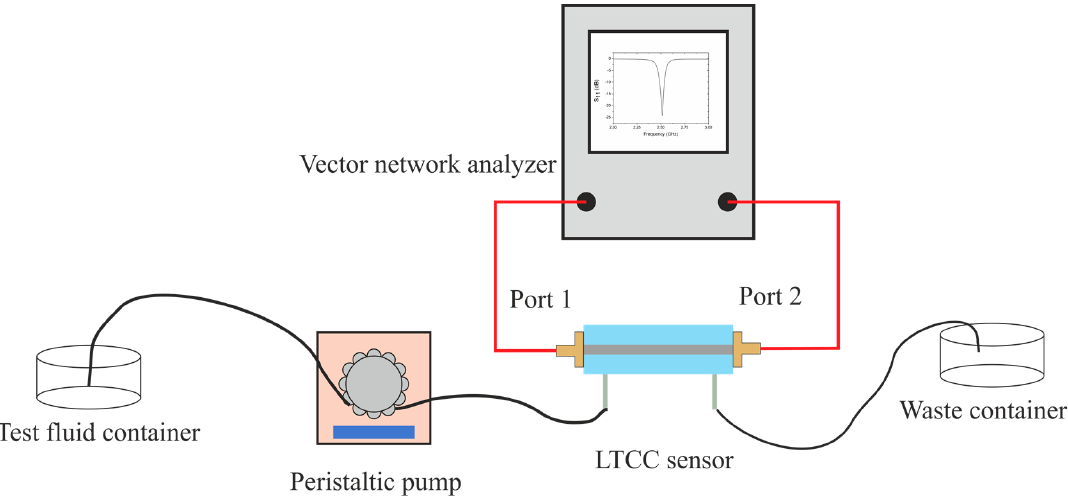
Figure 9. Scheme of the experimental test-bed used for testing the developed sensors.